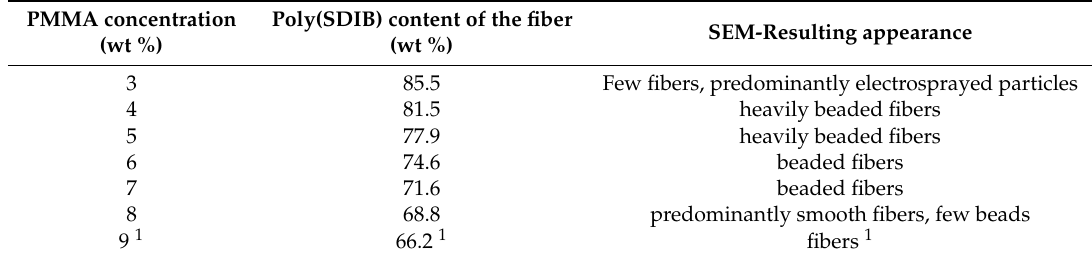
Table 1. Summary of conditions for electrospinning the poly(SDIB)/PMMA fibers with the resulting appearance, observed via SEM (Supporting Information, Figures S4–S9).